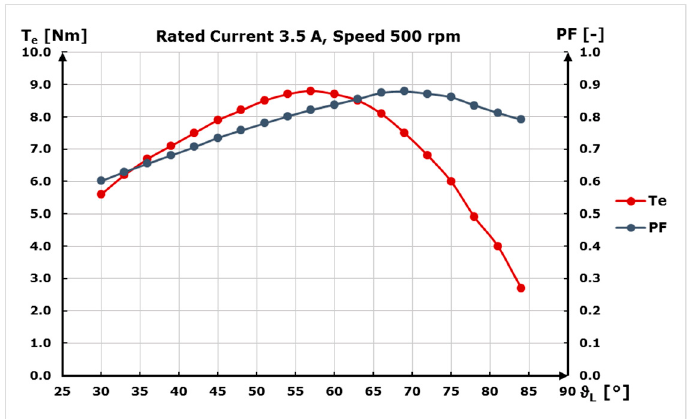
Figure 9. Torque and Power Factor versus load angle at 500 rpm and rated current.